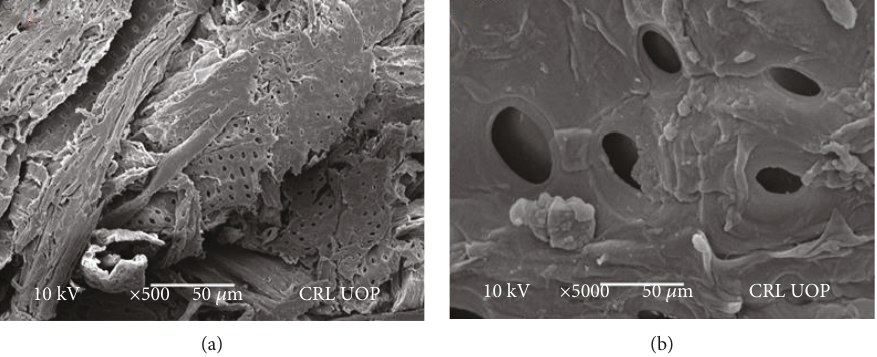
Figure 6: SEM micrograph of cellulose prepared from the wood of Eucalyptus lenceolata (X500 and X5000